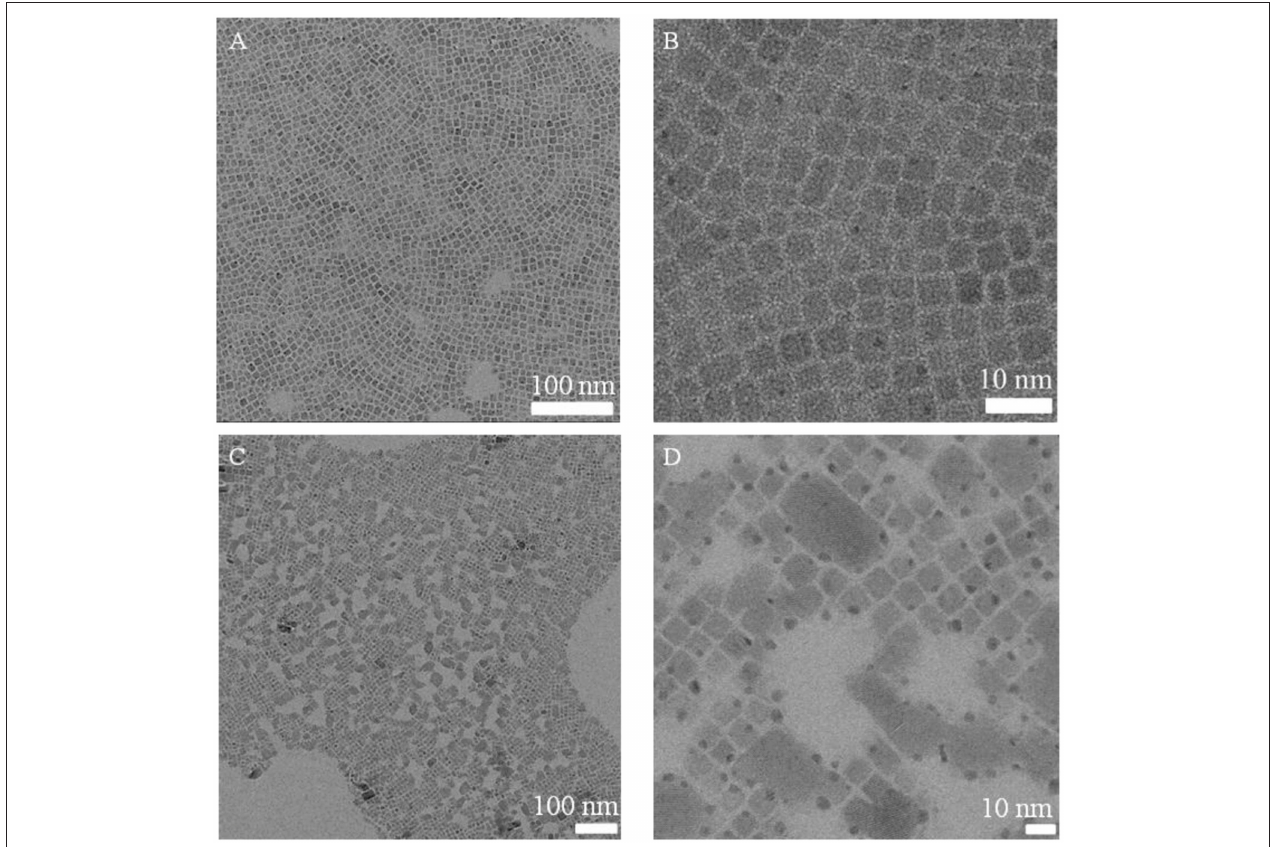
FIGURE 2 | TEM images of CsPbBr 3 NCs (A,B) and BPO oxidized CsPbBr 3 NCs ( C,D , 120min) with different magnifications.